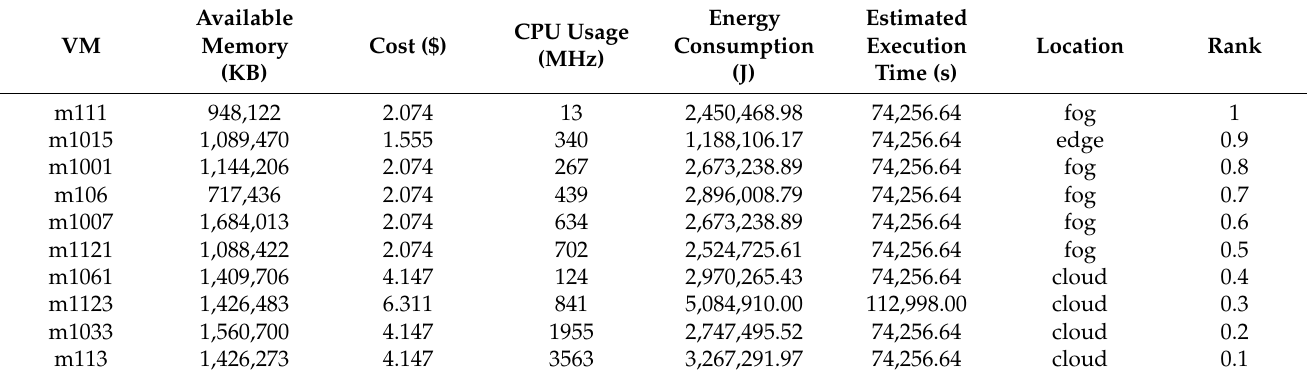
Table 16. Optimization results Task 318037 for a cost-driven and CPU utilization use case